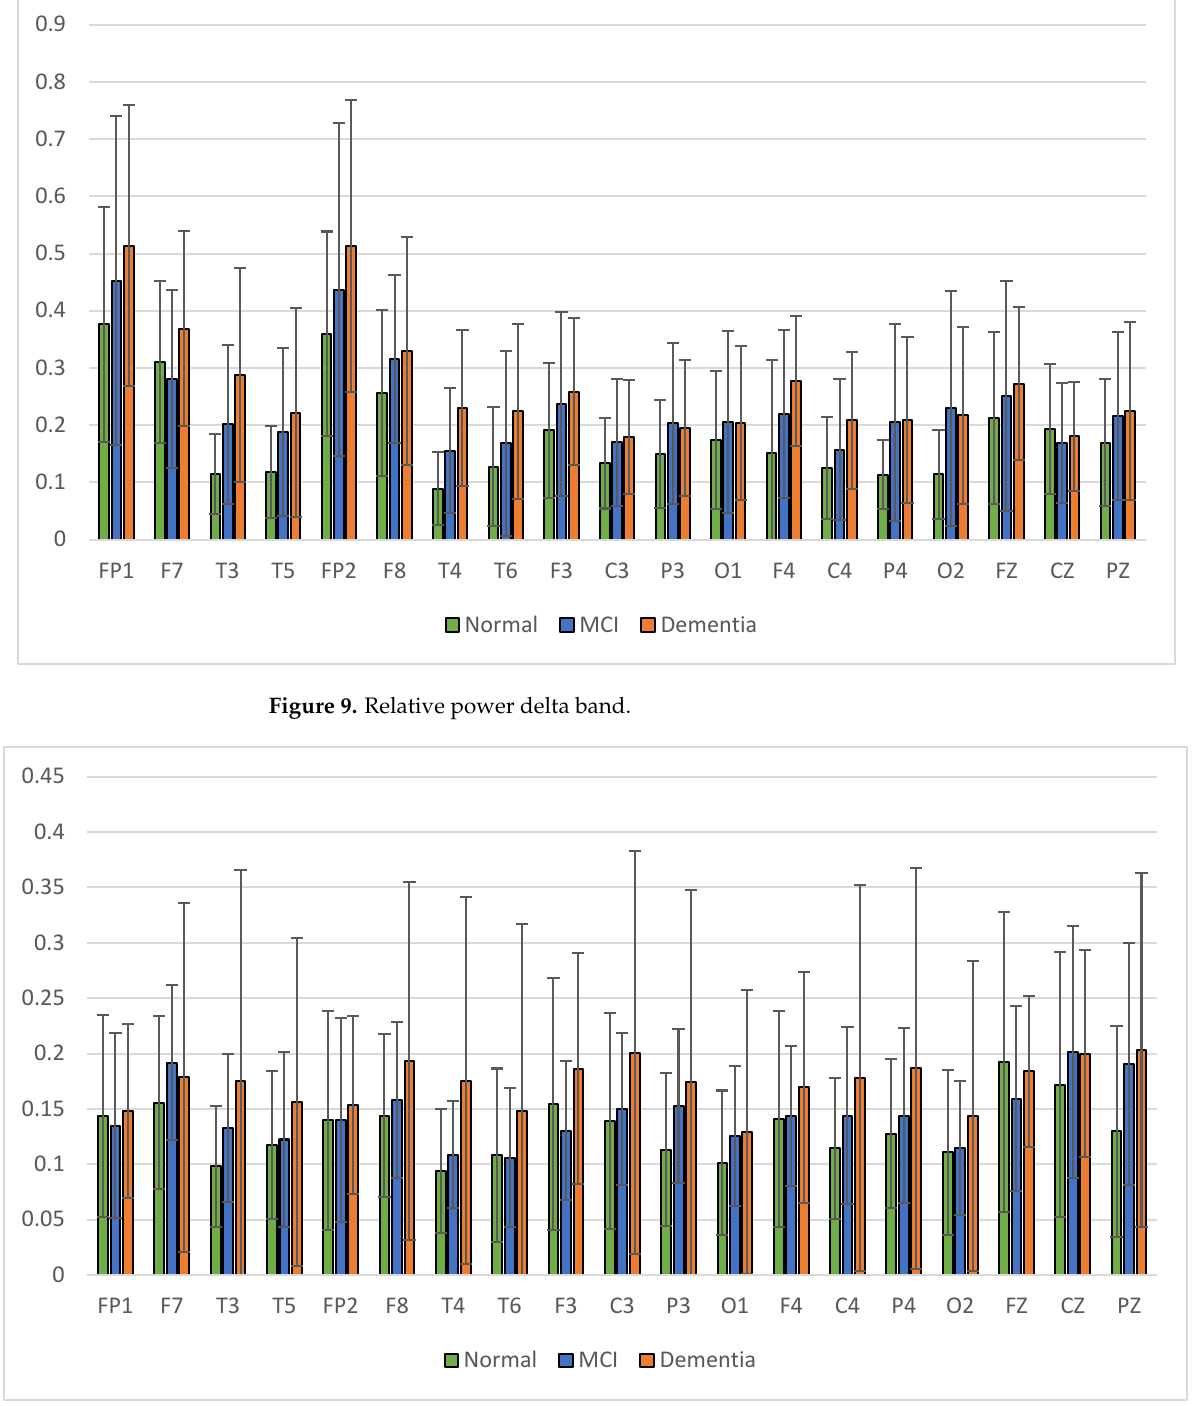
Figure 10. Relative power theta band.